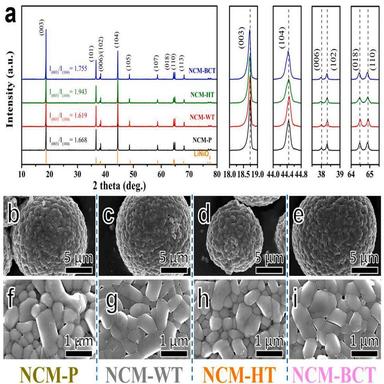
(a) XRD patterns of fresh NCM811 cathode materials with various treatments. (b-i) Morphological characterizations of fresh NCM811 cathode materials with various treatments.